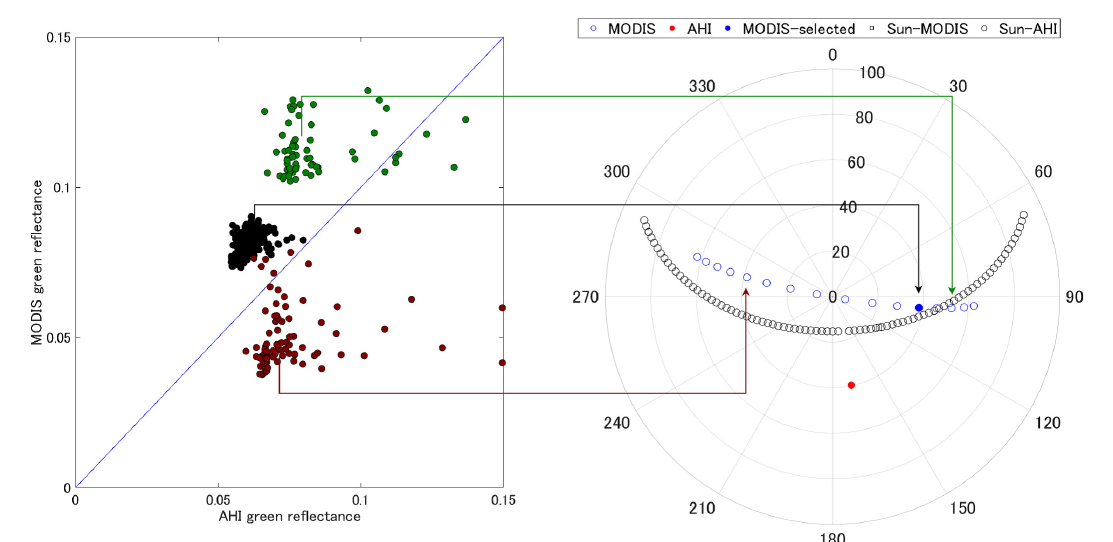
Figure 1. Scatter plot ( left ) of the TOC reflectances observed by AHI and MODIS, with the corresponding green bands. The data were extracted from our test site over the Kochi Forest during the period between 12 and 14 May 2016. The observation pairs over the three days are indicated by different colors. The data acquisition times of the three groups of reflectance pairs were nearly identical. ( right ) A polar plot of the illumination and view angles. Sixteen variations in the MODIS view angles (11–26 May 2016) are also